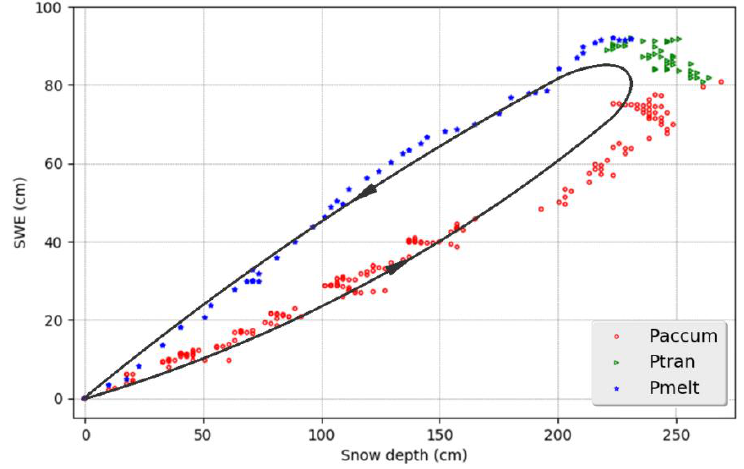
Figure 4. Typical variation of SWE versus snow depth over a snow season.